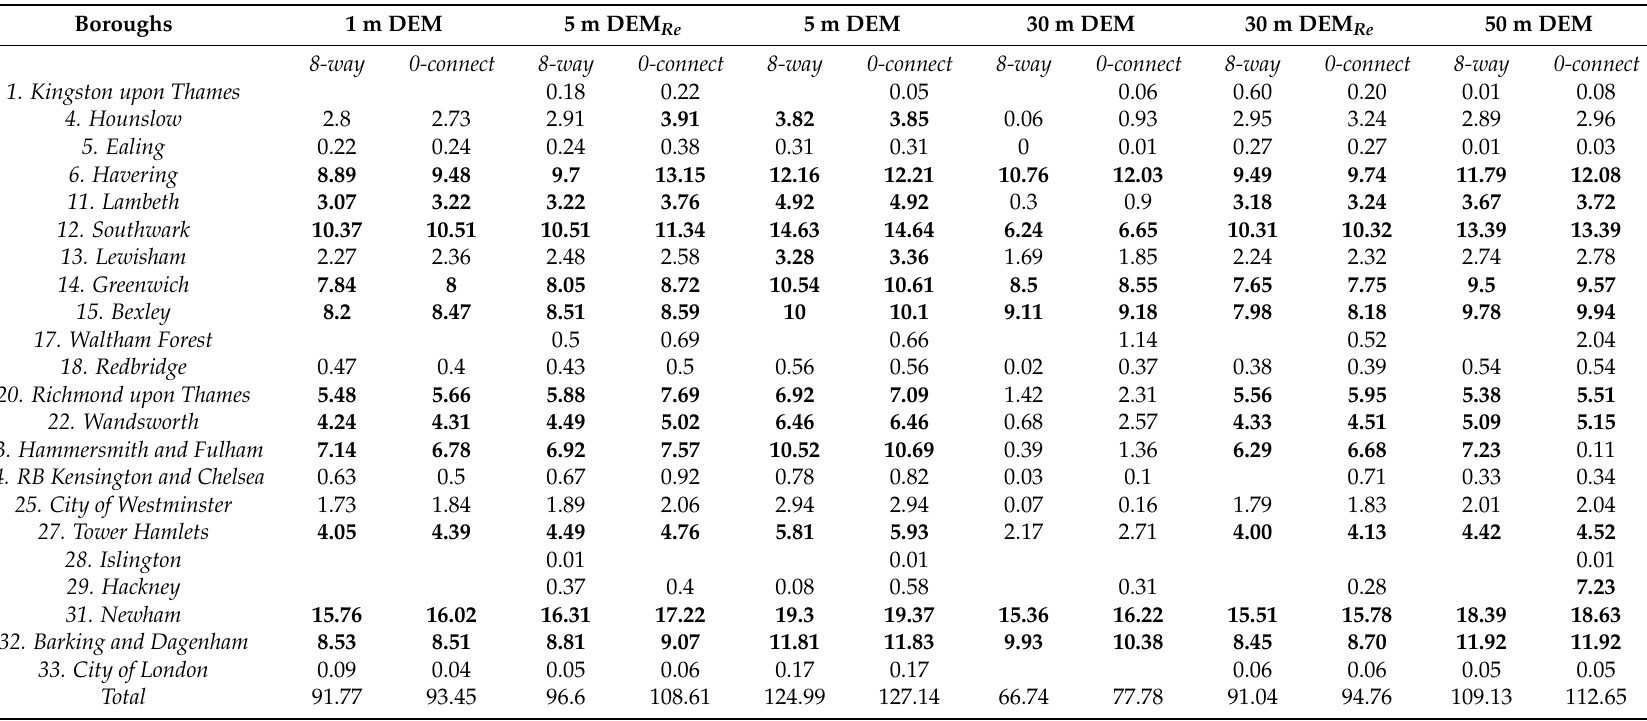
Table A3. Potential inundation areas for Greater London boroughs obtained from the 1.90 meter UKCP09 high++ London sea-level rise scenario as estimated from six different elevation datasets (Section 2.1) and two different connectivity (eight-way hydrological and zero) approaches (Section 2.2). Only the boroughs that will be impacted are included (compare with Figure 1). Bold values indicate boroughs having ě 3 km 2 inundation